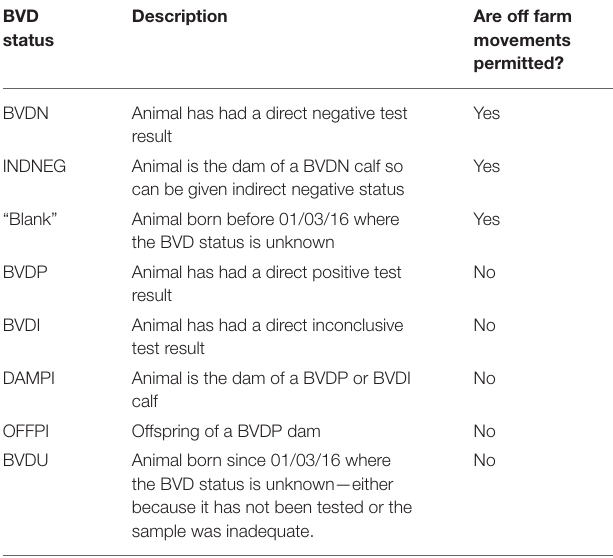
TABLE 1 | Description of the BVD statuses used within the AHWNI BVD eradication